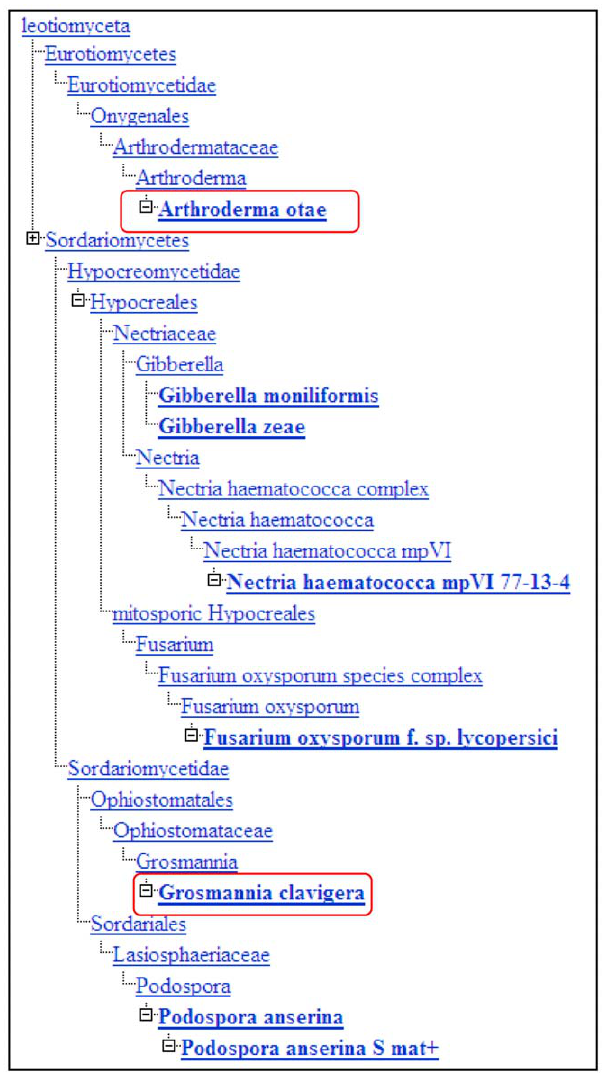
Figure 1. Taxonomic lineage of homologs to the HET-s PFD. The expanded taxonomic lineage of all species is presented. Actual species of HET-s PFD homologs are highlighted in bold and underlined. The non-significant PFD homologs from Arthroderma otae and Grosmannia clavigera (red boxes) are also included for comparison.